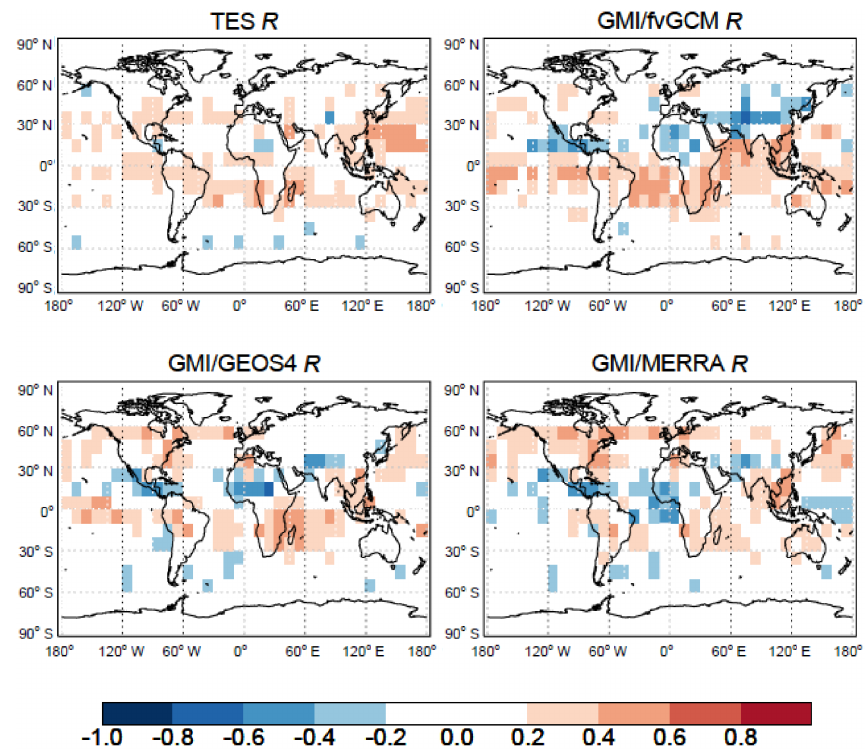
Figure 13. O 3 –CO correlation coefficients ( R ) at 618hPa as determined by O 3 and CO observations from TES during July–August 2005, and corresponding GMI CTM results with 3-hourly output sampled along the TES orbit tracks. TES averaging kernels, spectral errors, and a priori are applied. Results are calculated in 10 ◦ × 10 ◦ grid cells. White areas denote absolute values of O 3 –CO correlation coefficients less than